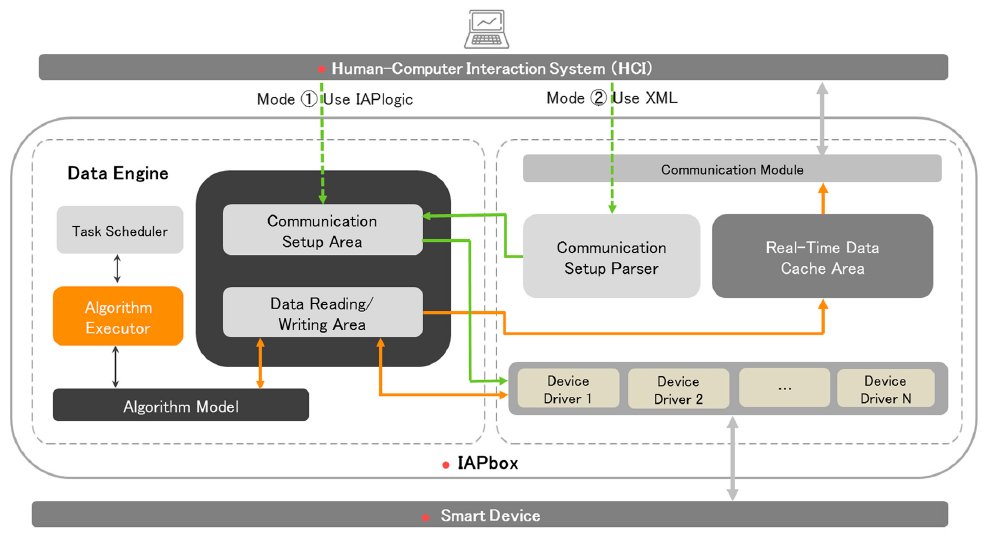
Figure 3. Network communication principle of the controller.